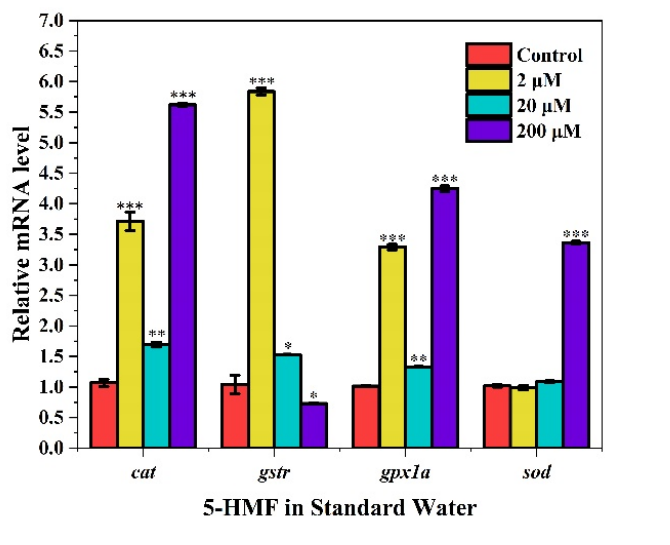
lower in all groups compared with the exposure dose, with a maximum of only